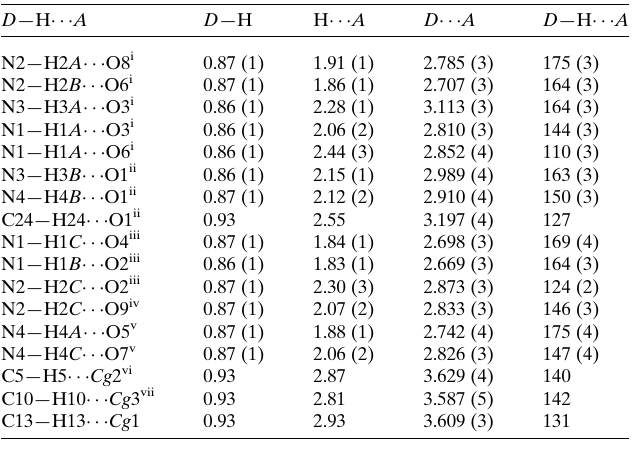
Table 1 Hydrogen-bond geometry (A˚ , (cid:4) ). Cg 1, Cg 2 and Cg 3 are the centroids of the C1–C6, C8–C13 and C15–C20 rings, respectively.